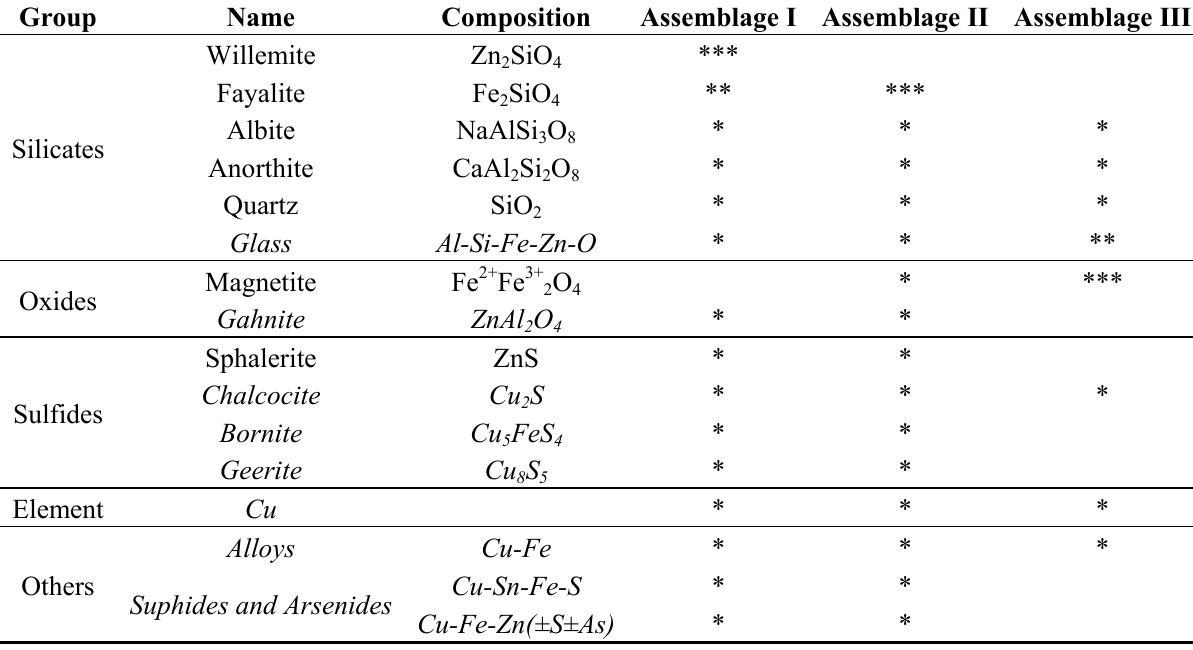
Table 1. Primary phases and subsidiary phases of the slag obtained by X-ray powder diffraction analysis (XRD) and energy dispersive spectrometer (EDS) (normal: both methods; italics: only